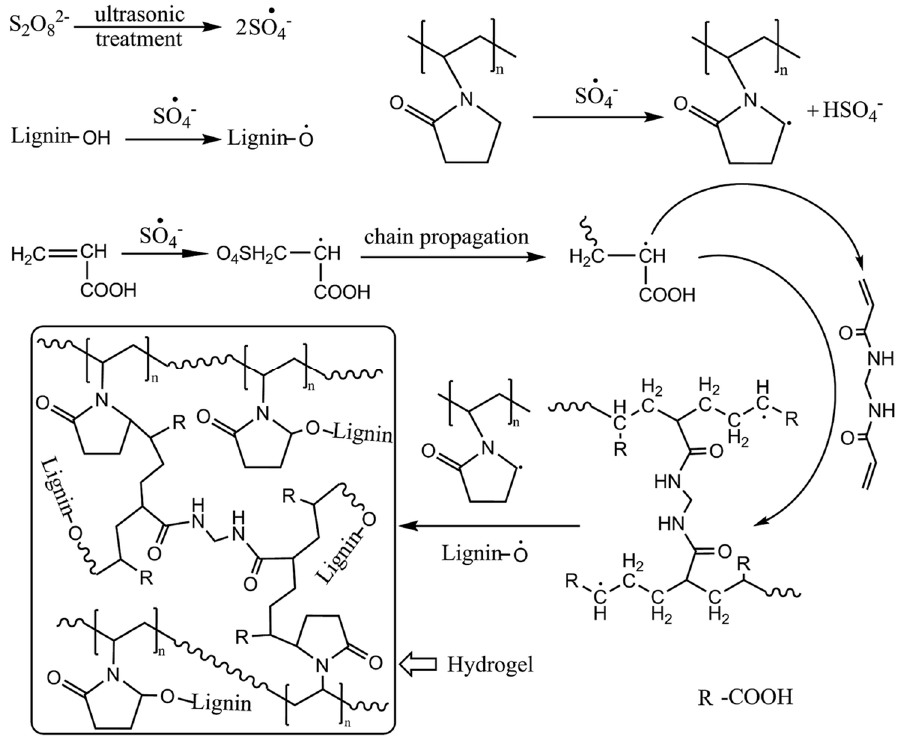
Figure 10. Representation of the synthesis of sodium lignosulphonate-grafted poly(acrylic acid-co-poly(vinyl pyrrolidone)) hydrogels. (Reproduced with permission from Wang et al. [62]. Table 1. Main synthetic strategies described in the bibliography for the development of lignin based hydrogels.